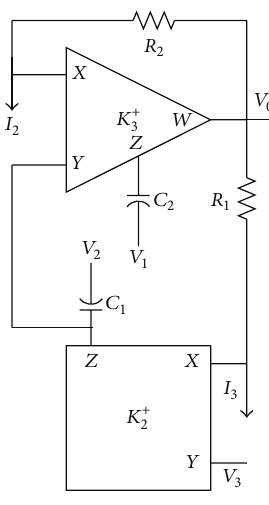
Figure 6: Third derived